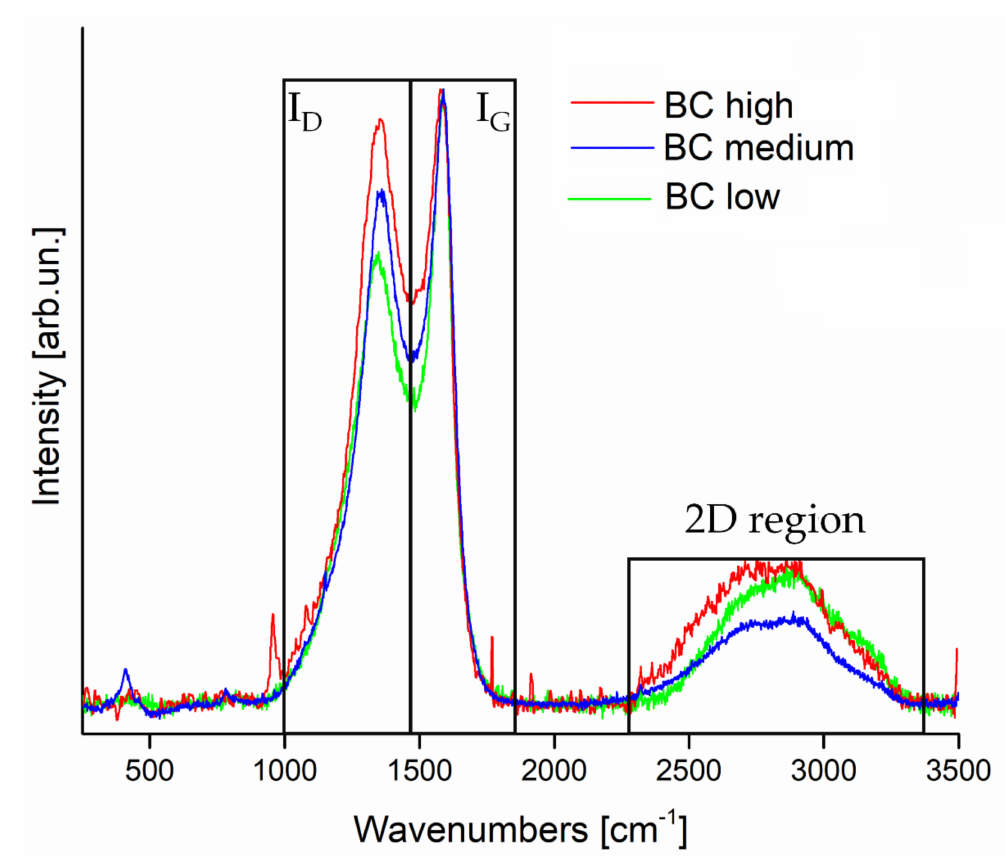
Figure 2. Raman spectra of BC low (green), BC medium (blue), and BC high (red) in the range from 250 cm − 1 to 3500 cm − 1 . Spectra are normalized to I G